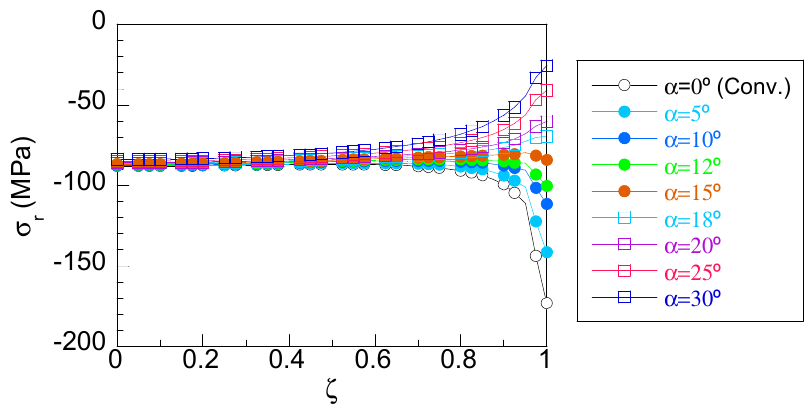
Figure 7. Hub axial distribution of radial stress at the shaft–hub interface.